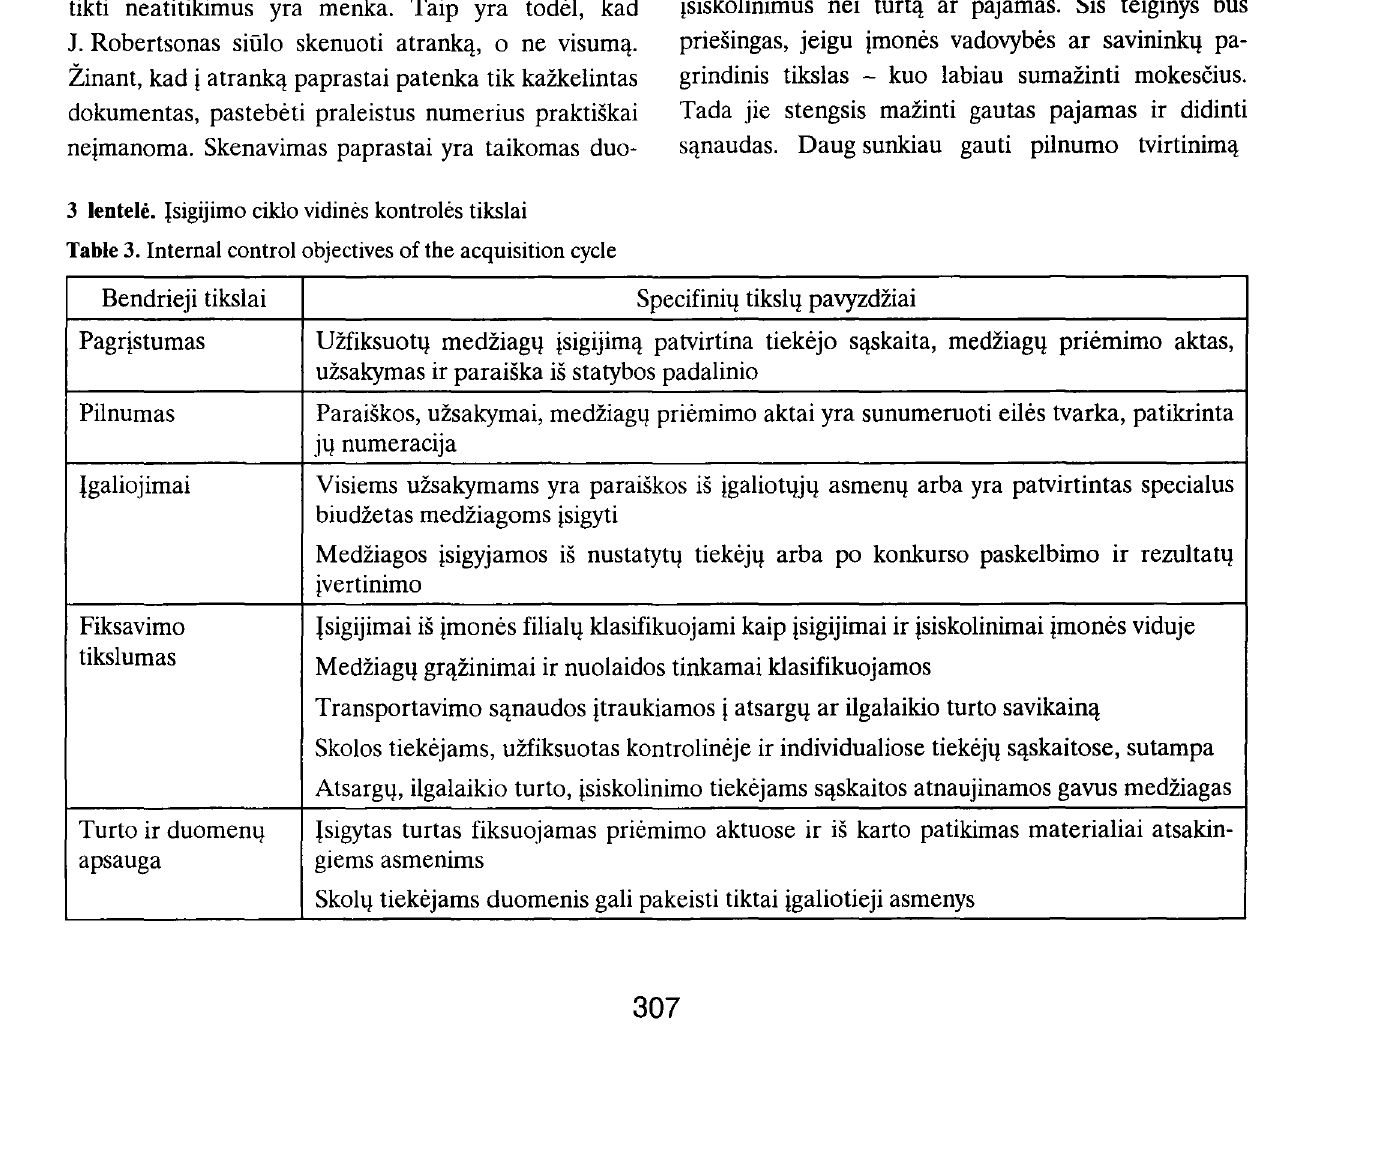
Table 3. Internal control objectives of the acquisition